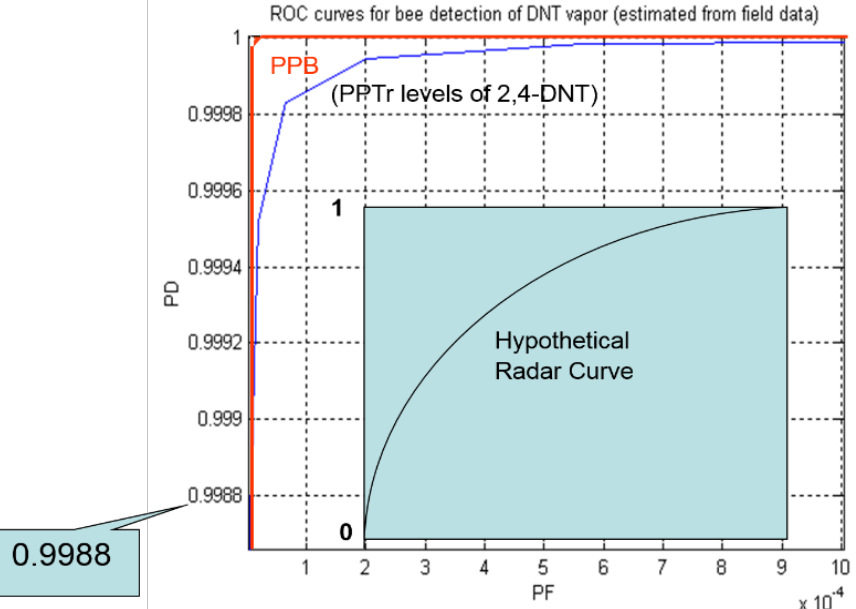
Figure 14. Receive Operating Characteristic curve (ROC) for bee detection of 2,4-DNT in soil, derived from DARPA funded trials, based on a figure we provided to a Rand report on Alternatives to Landmine Detection, 2003